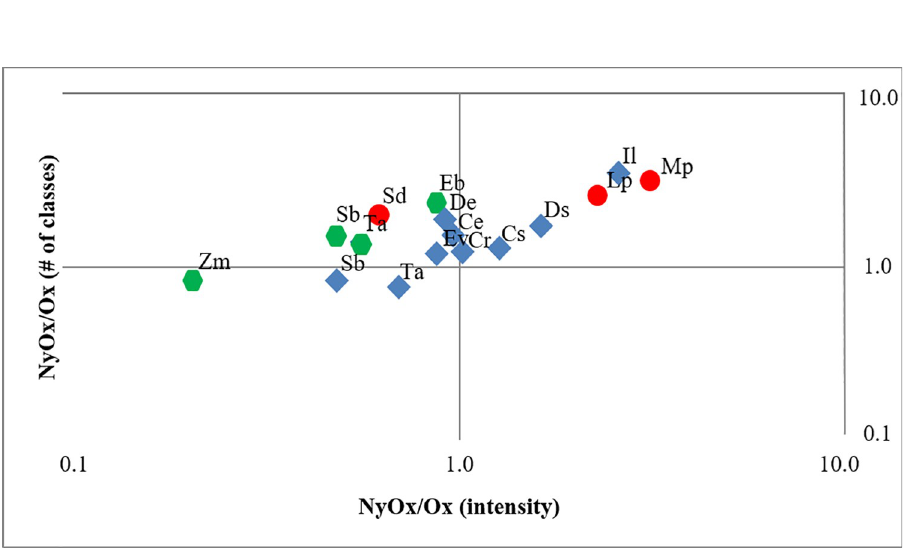
Fig 4. Compound class variation for nitrogen- and oxygen-containing NyOx, and oxygen-only Ox species. Relative intensity and number of compound classes from the Maillard reaction products generated by the reaction of starch mixed with glycine. FTICR-MS analysis, through electrospray ionization in negative ion mode. Initials are from the taxa listed in Table 1.